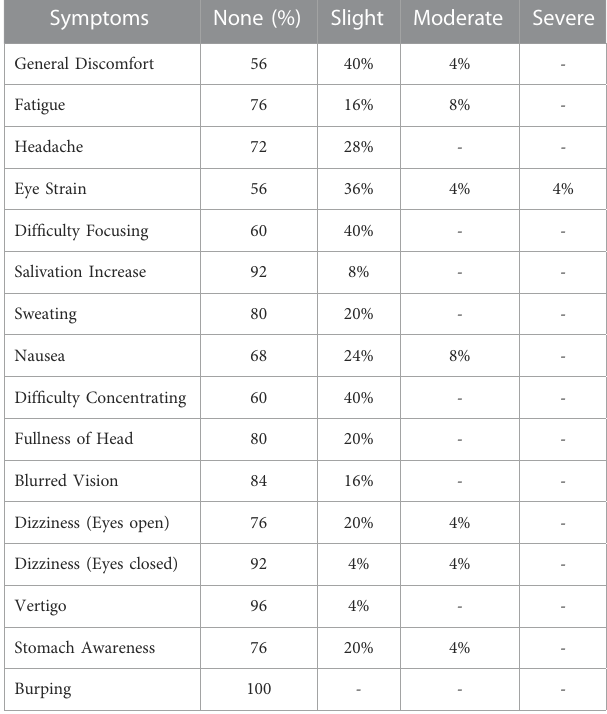
TABLE 2 Simulator Sickness Questionnaire individual items analysis. Data are presented as percentages reported by total